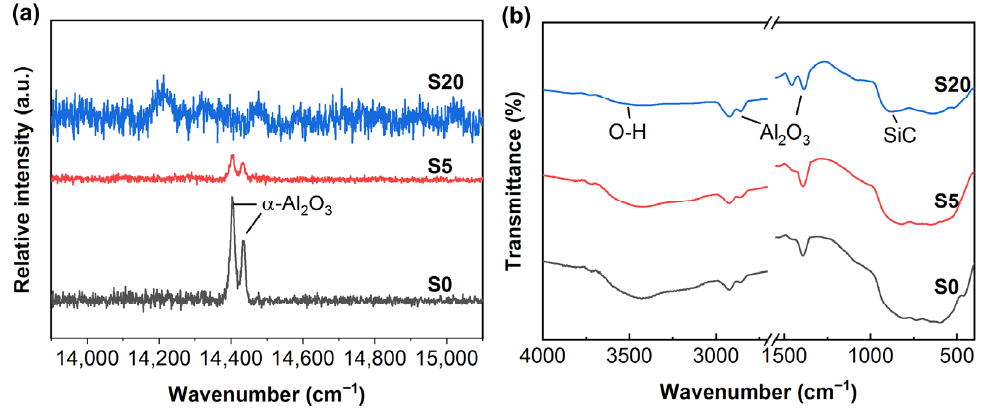
Figure 3. Luminous spectra of CPED coatings: ( a ) Raman spectra; ( b ) FTIR spectra.